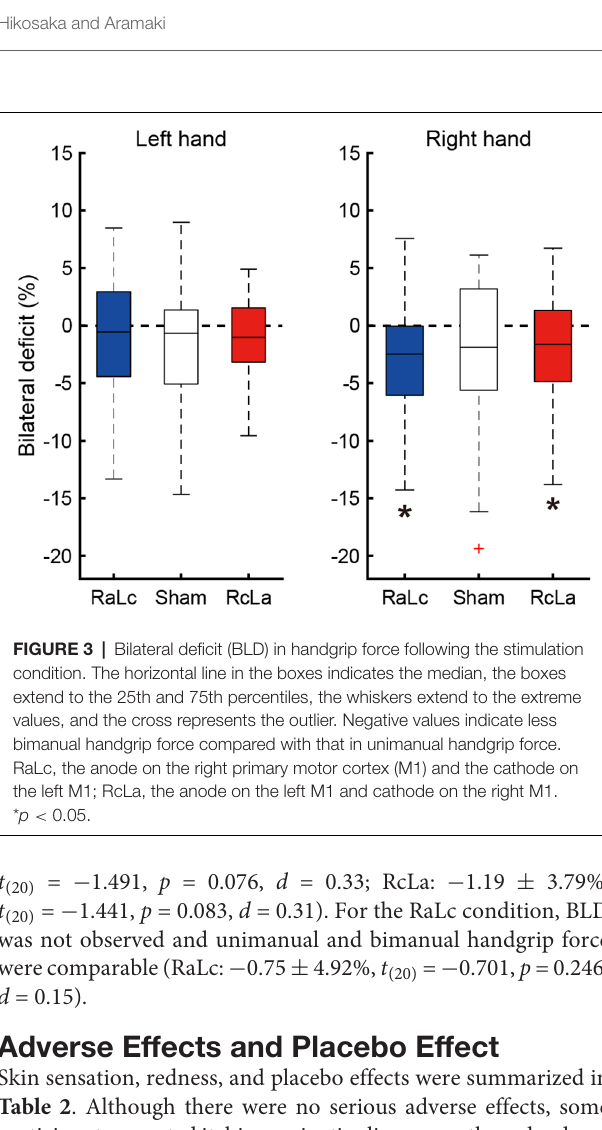
t (20) = − 1.491, p = 0.076, d = 0.33; RcLa: − 1.19 ±